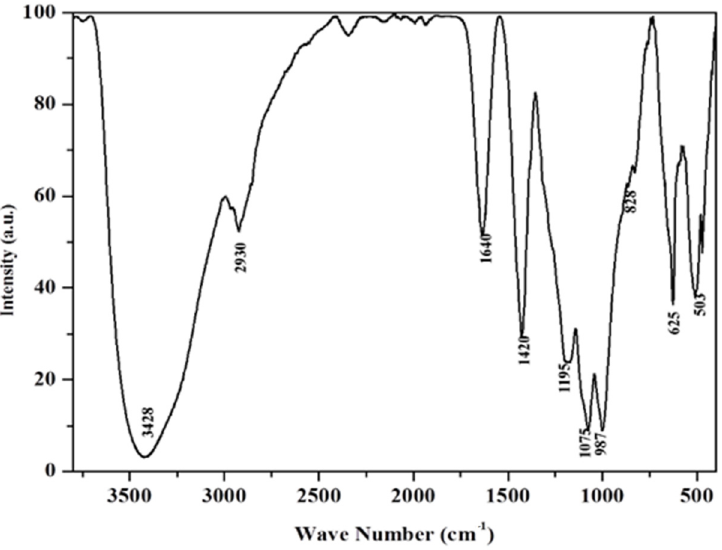
Figure 3. Infrared spectrum of the obtained ammonium-sodium jarosite with arsenic.